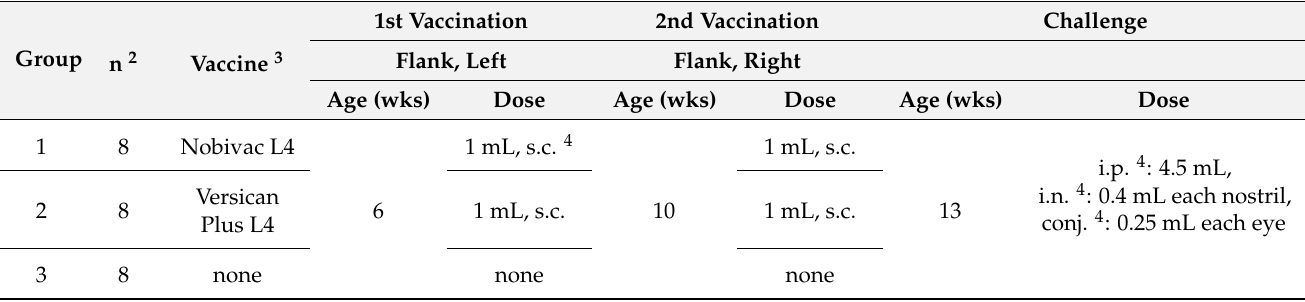
Table 1. Treatment schedule of studies 1–4 1 : grouping, dosage and